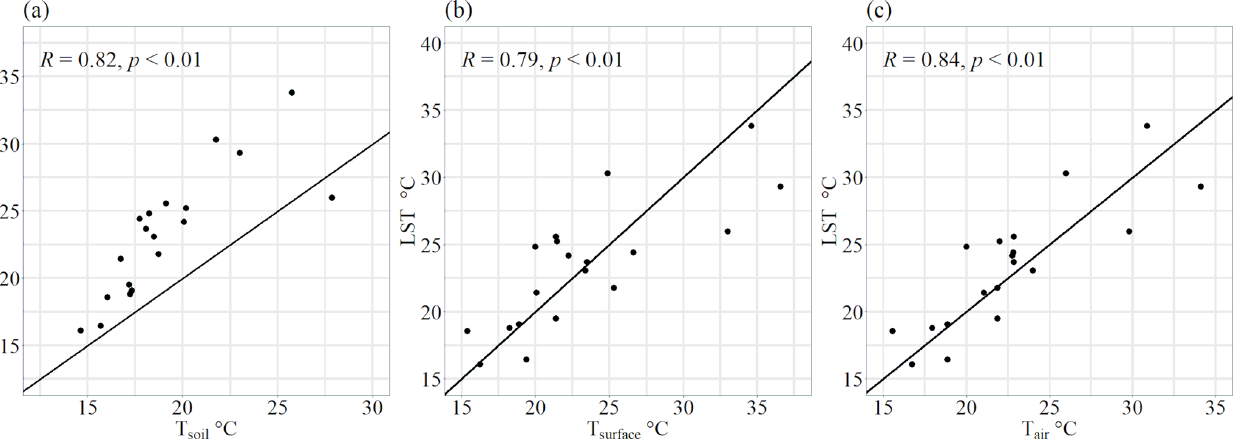
Figure 6. Landsat 8 land surface temperature (LST) compared with raw field temperatures ( T ) at the time of satellite overpass (10:30) on 4 July 2019. (a) LST and soil temperature. (b) LST and surface temperature. (c) LST and air